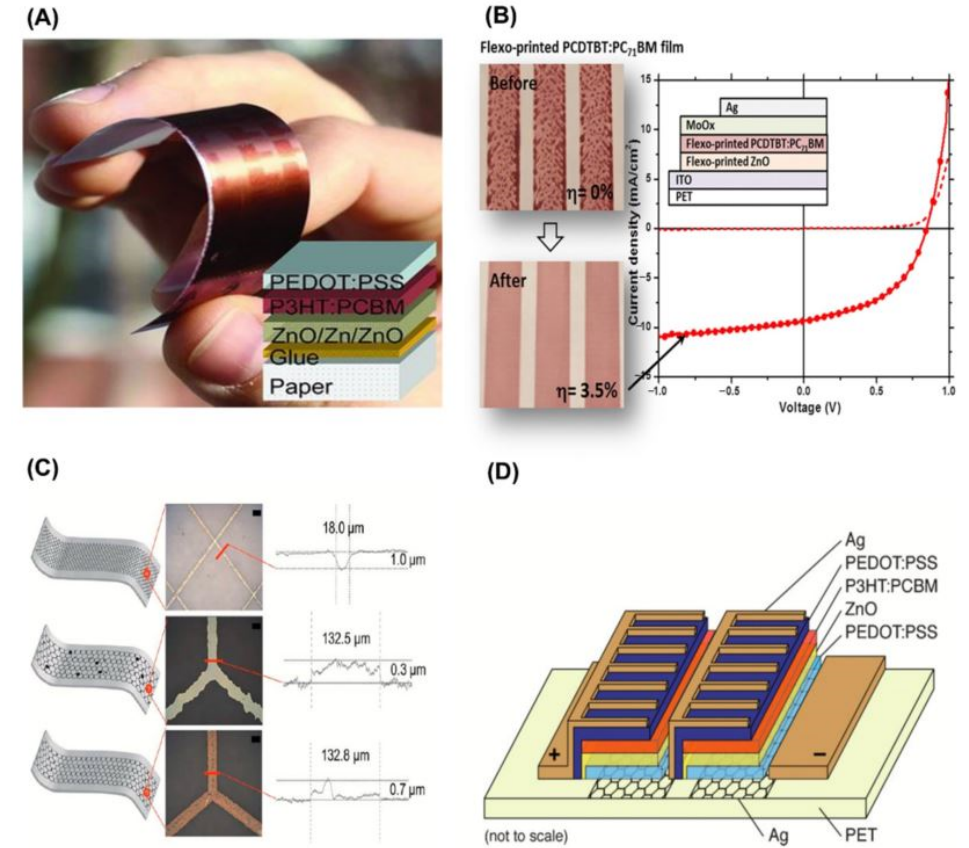
Figure 5. ( A ) Photograph of the printed paper photovoltaic cell. Reproduced with permission. Ref. [53] Copyright 2011. John Wiley and Sons. ( B ) J-V characteristics in dark (dashed line) and under AM1.5 illumination of 100 mW/cm 2 (circles). The inset illustrates the device structure. Reproduced with permission. Ref. [64] Copyright 2018. Elsevier. ( C ) Schematic illustrations of the different grid structures ( ∼ 5 cm × 1 cm) along with optical confocal micrographs (scale bar is 100 mm) and traces across the grid lines showing the typical width and height (from the confocal micrograph). The thermally imprinted grid with Ag filling (top). Inkjet is shown (middle) with an illustration of the occasional presence of misfired ink droplets and the irregular structure of the grid lines, compared to the more regular flexographically printed grids (bottom). Reproduced with permission. Ref. [69] Copyright 2012. Royal Society of Chemistry. ( D ) Illustration of the fully R2R processed solar cell stack comprising the following materials: silver Ag, PEDOT:PSS, zinc oxide (ZnO), and P3HT:phe- nyl-C 61 -butyric acid methyl ester (P3HT:PCBM). The last Ag back electrode is printed using four different techniques. Reproduced with permission. Ref. [70] Copyright 2013. John Wiley and Sons. Table 2. Summary of flexographic printing technique on polymer solar cells.